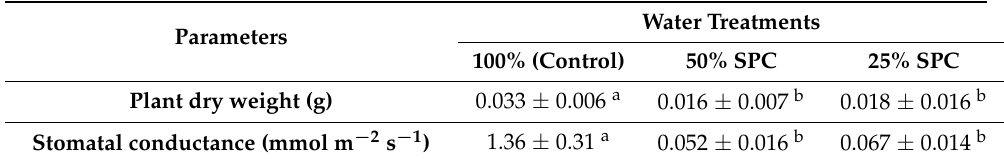
Table 1. Plant dry weight and stomatal conductance of S. viridis plants grown at 100% (control), 50%, and 25% of soil pot capacity